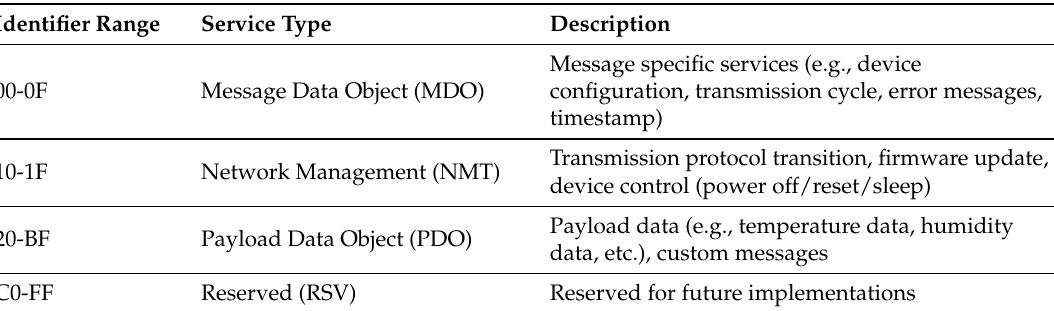
Table 2. Semantic data services